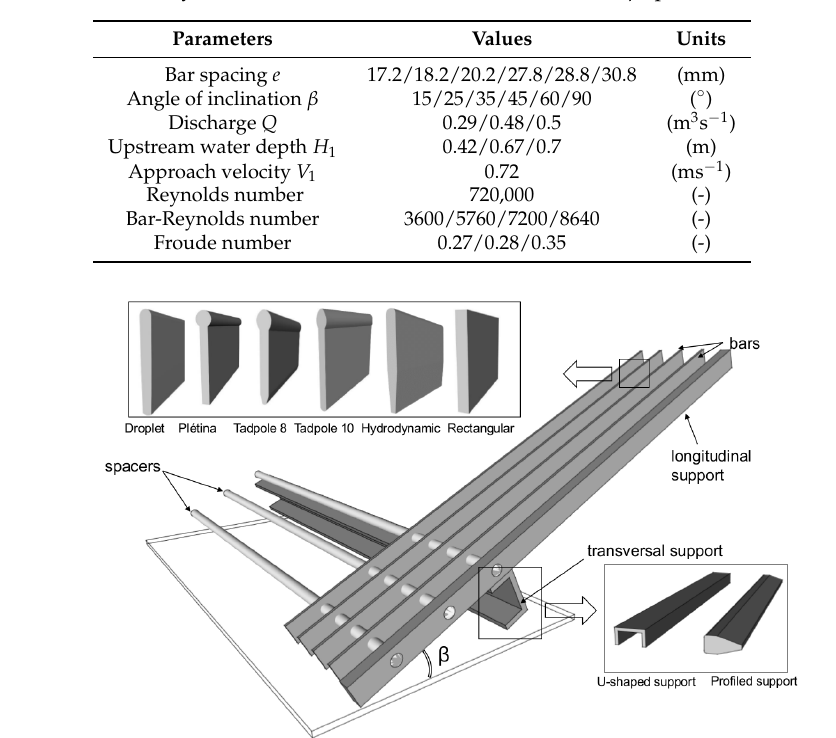
Table 1. Hydraulic (Q, H 1 , V 1 , Re, Fr) and trash rack (e, β ) parameters.